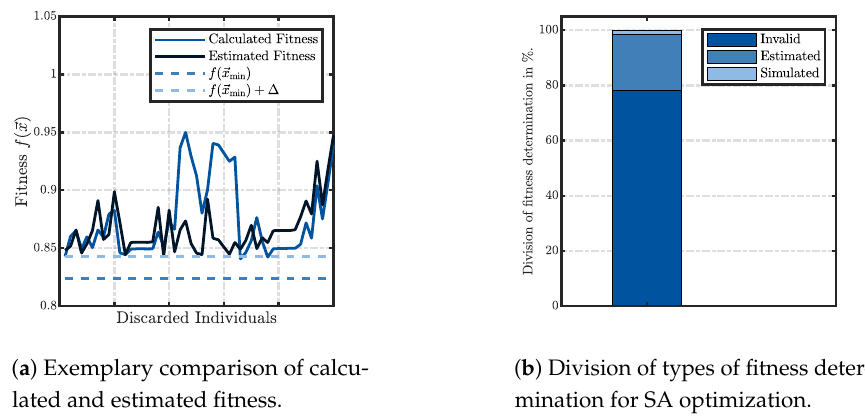
Figure 6. Exemplary comparison of calculated and estimated fitness ( a ) and the breakdown of fitness determination ( b ).